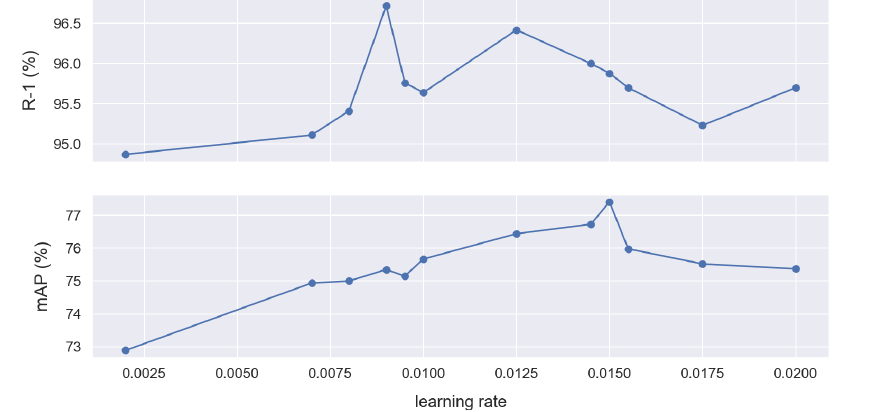
Figure 12. The mAP and R-1 scores in % for different learning rate values using L id , L tri , L cen and the BNNeck. Table 10. Performance of the models using different learning rates. The loss function is the same for all experiments. BNNeck Learning